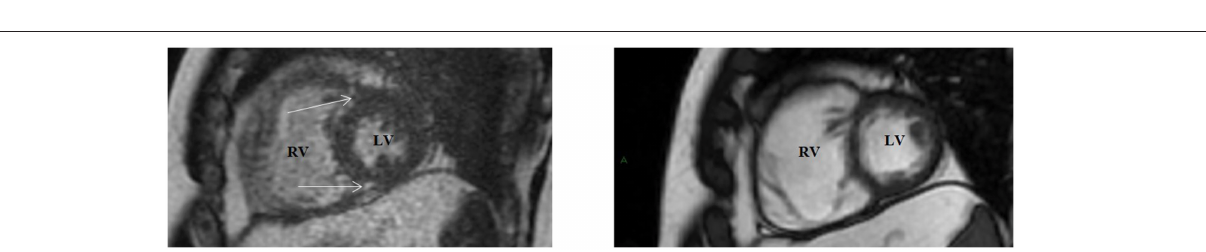
FIGURE 6 | Delayed enhancement (DE) cardiac magnetic resonance in the short-axis view (Left) showing gadolinium hyperenhancement at the right ventricular septal insertion points (arrows), with corresponding slice on cine imaging (Right) showing right ventricular enlargement. LV, left ventricle; RV, right